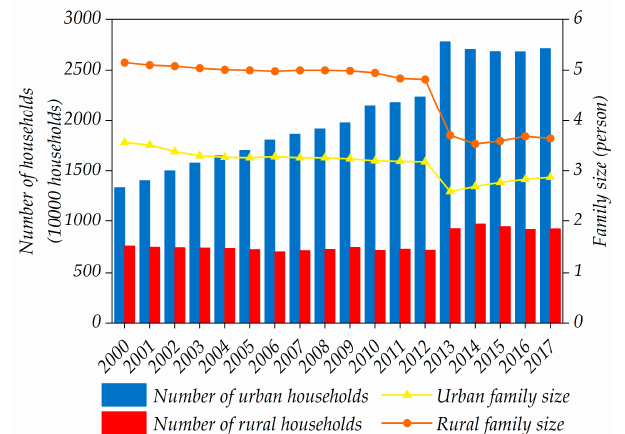
Figure 7. The number of households and family size in Guangdong urban and rural regions during 2000–2017.